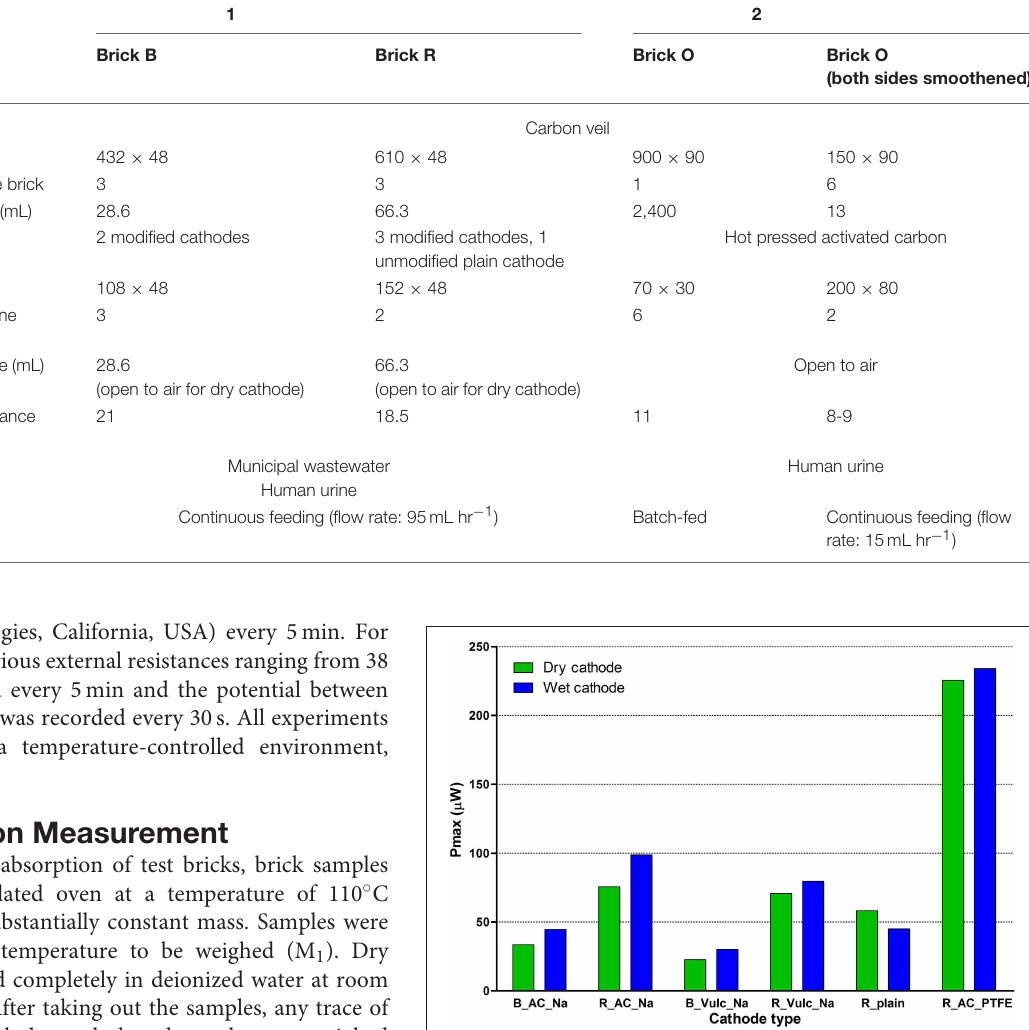
FIGURE 2 | Maximum power output from polarisation measurements of the test cathode types of Type 1 test bricks. Polarisation was performed between single anode and cathode of each